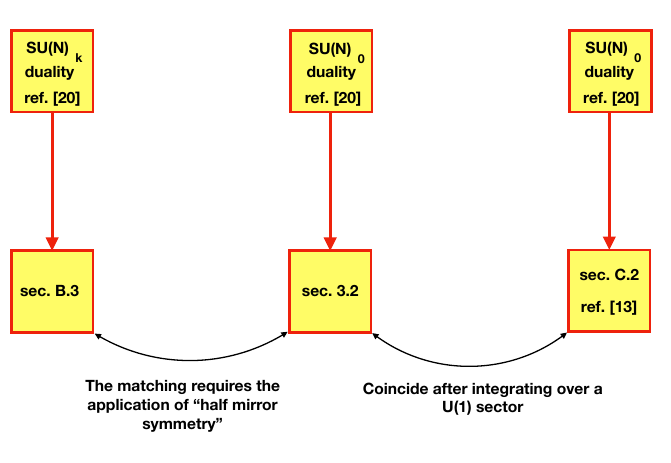
Figure 2 . The various real mass flows leading to the [ p, 0] case studied in this paper and their relation. We report the references corresponding to the UV duality where the RG flows considered here